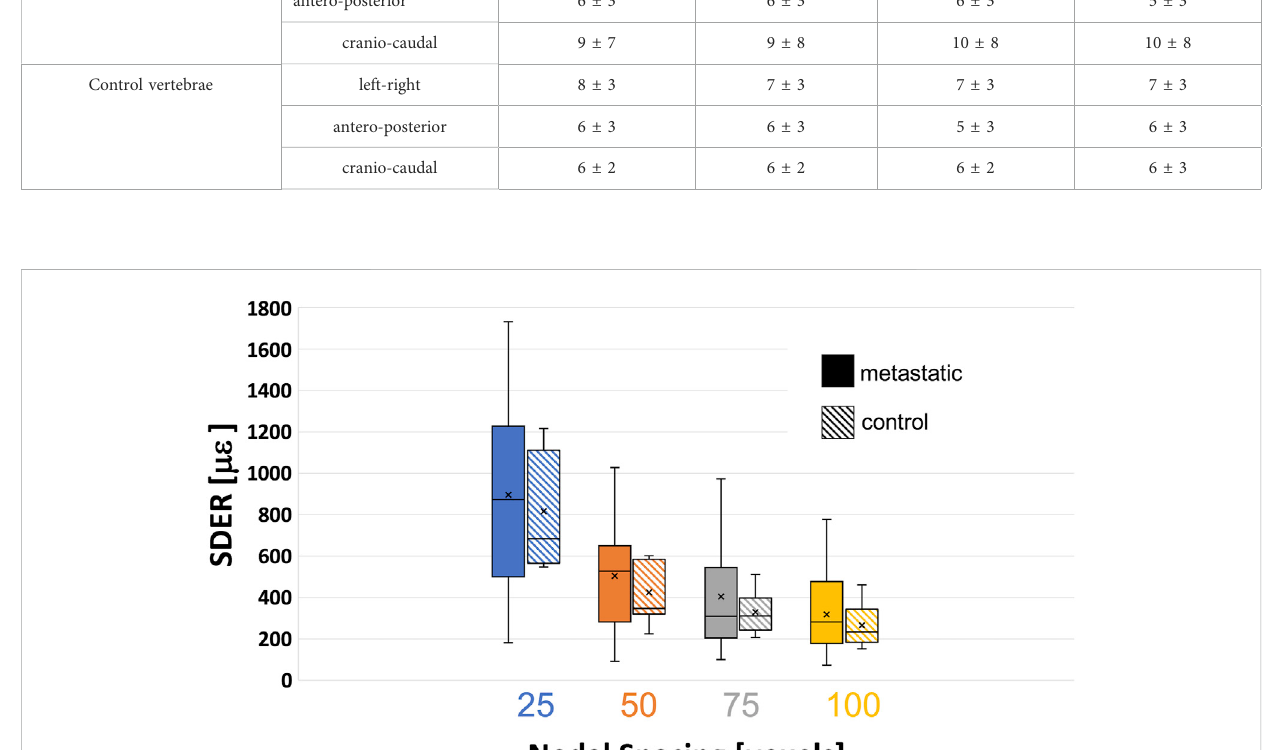
FIGURE 4 Variability of the standard deviation of the error (SDER) in metastatic and control vertebrae in VOI_DVC for different nodal spacing of 25 voxels (0.975 mm)in blue, 50 voxels (1.95 mm) in orange, 75voxels (2.925 mm) in grey, and 100 voxels (3.9 mm) in yellow. The box is limited by the fi rst and the third quartile. Whiskers represent the lowest and highest data point in the data set excluding any outliers. Mean and median values among the group are represented by the cross and the horizontal line,